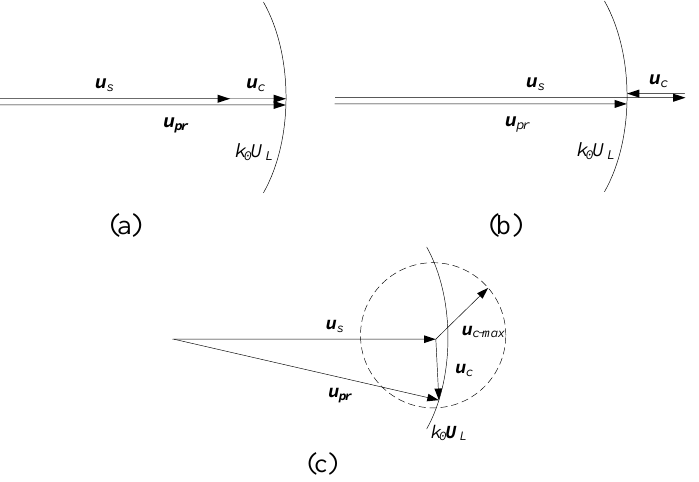
Figure 4. Voltage phasor diagram of flexible OLVR. ( a ) The same direction compensation scheme, ( b ) The reverse direction compensation scheme, ( c ) Arbitrary direction compensation scheme.